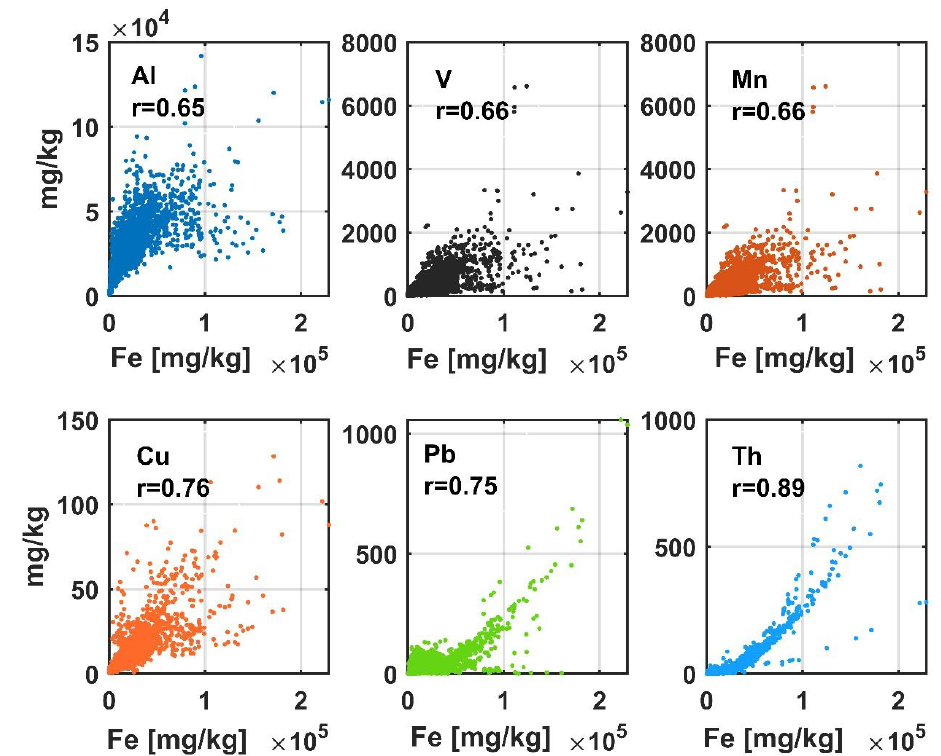
Figure 6. Scatter plots of the content of selected elements as a function of Fe content. Similar relationships exist between the exchangeable bases and the elements in- cluded in them (Figure 7). The exchangeable bases value is shaped by Ca to the largest extent, although the association with K and Mg is also significant. Calcium content, fairly well identified through the MIR spectral response, is nonlinearly related to pH. It is diffi- cult to indicate which of these elements is the primary basis for correct modeling of soil sorption elements.